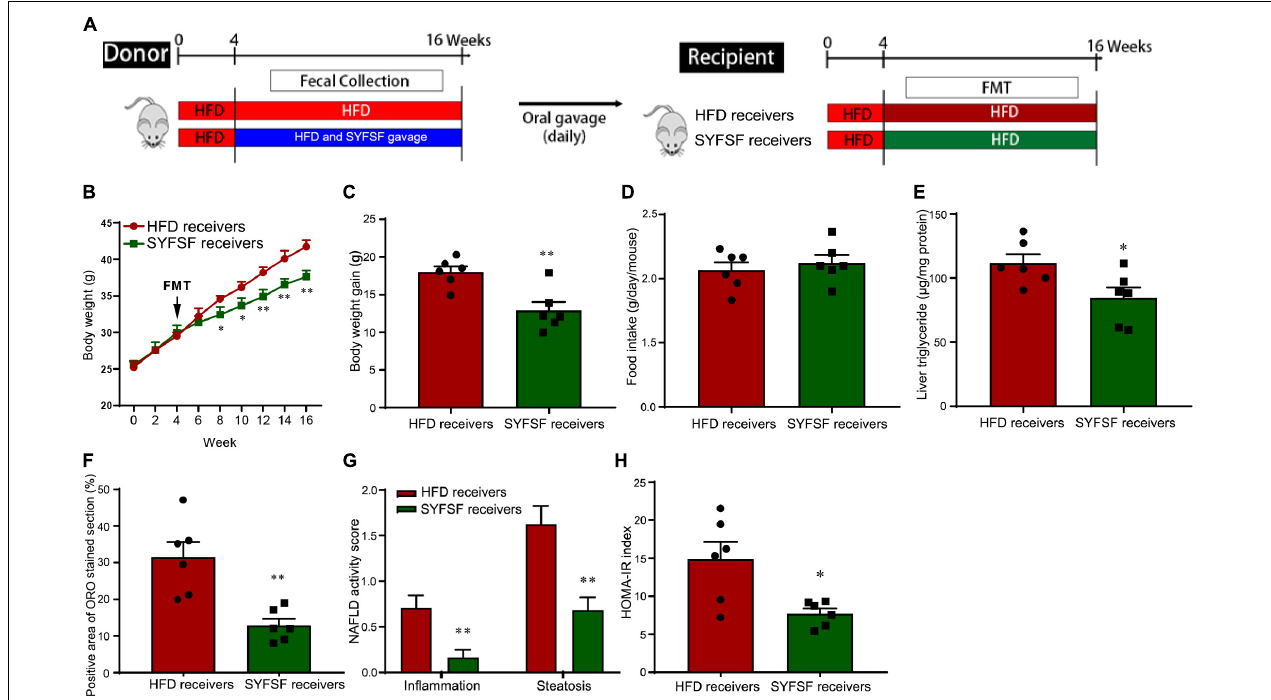
FIGURE 4 | Obesity-associated metabolic syndrome is reversed by feces transfer from SYFSF-treated mice to HFD-fed mice. (A) A schematic diagram for the experimental timeline. Horizontal fecal transfer from vehicle–treated HFD mice is referred to as HFD receivers. Horizontal fecal transfer from SYFSF-treated mice is referred to as SYFSF receivers. (B) Body weight. (C) Body weight gain. (D) Food intake. (E) Liver TG. (F) Liver lipid accumulation was assessed by Oil Red O staining. (G) NAFLD activity score. (H) HOMA-IR index was calculated according to the formula: fasting insulin (mU/L) × fasting glucose (nmol/L)/22.5. ∗∗ P < 0.01, ∗ P < 0.05 vs. HFD receivers. n = 6 per group.